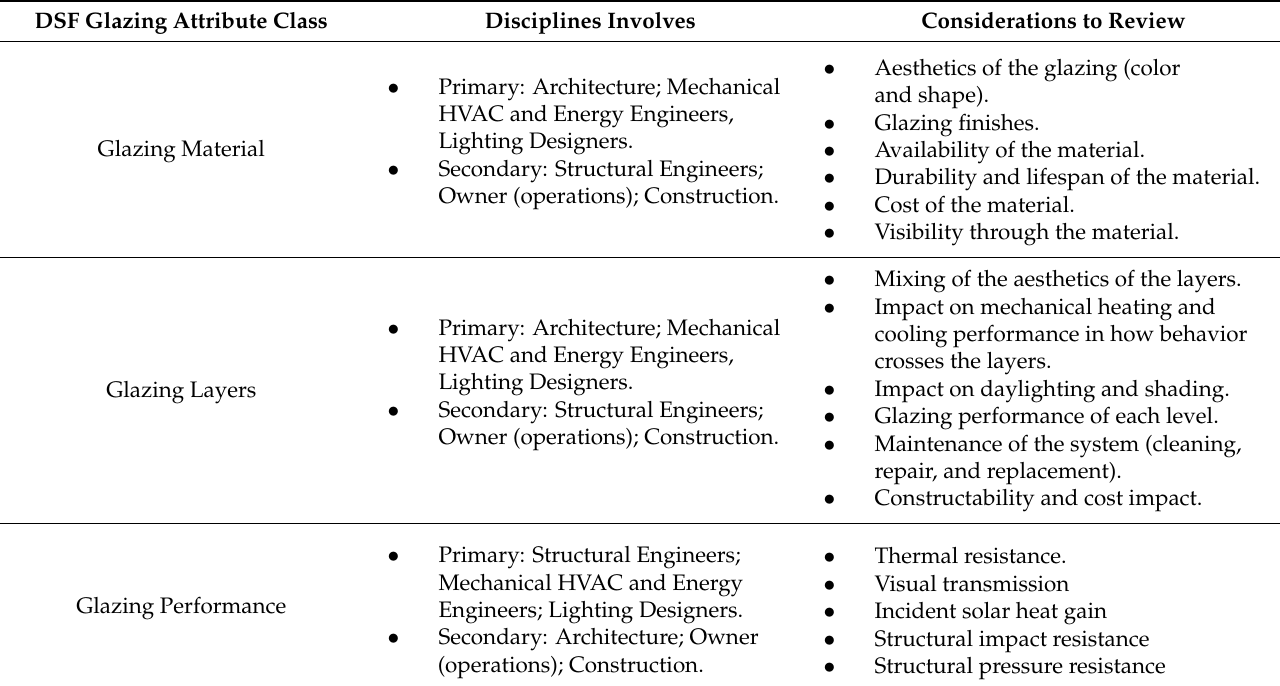
Table 7. Multi-disciplinary Consideration Takeaways of